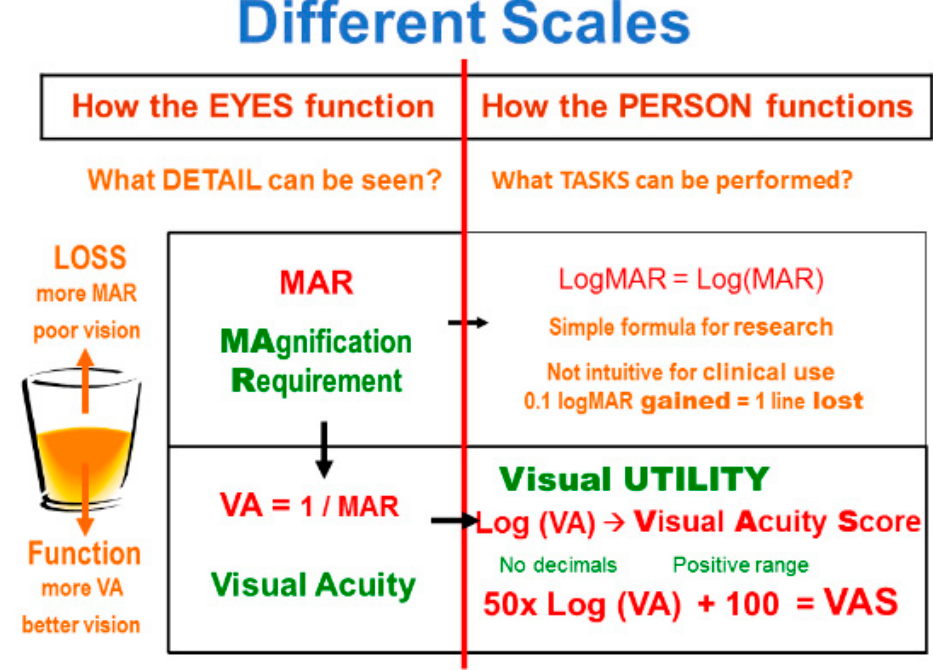
Figure A2. Scales for detail vision.